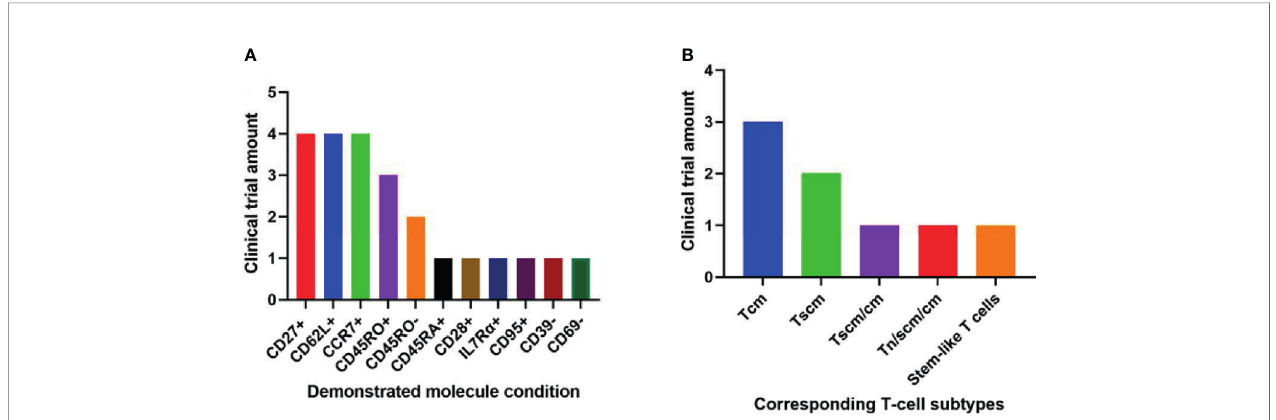
FIGURE 2 | Phenotypic molecules (A) and T-cell subtype combinations (B) that have been demonstrated signi fi cantly associated with anti-cancer therapeutic outcomes in different amounts of clinical